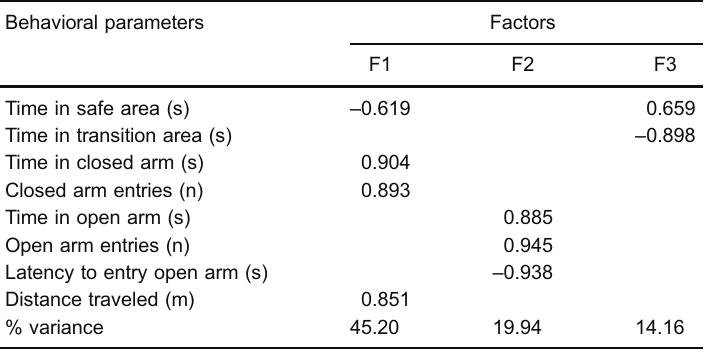
Table 3. Orthogonal factor loadings for main spatiotemporal and behavioral measures of the elevated gradient of aversion test. Behavioral